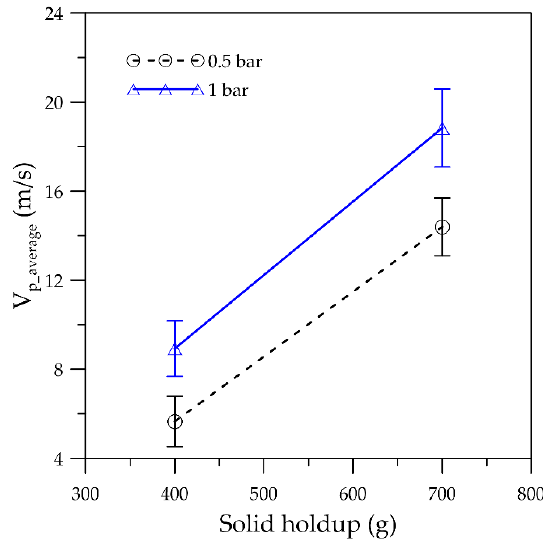
Figure 5. Time-averaged volumetric particle velocity as a function of the solid holdup and the nozzle inlet pressure.